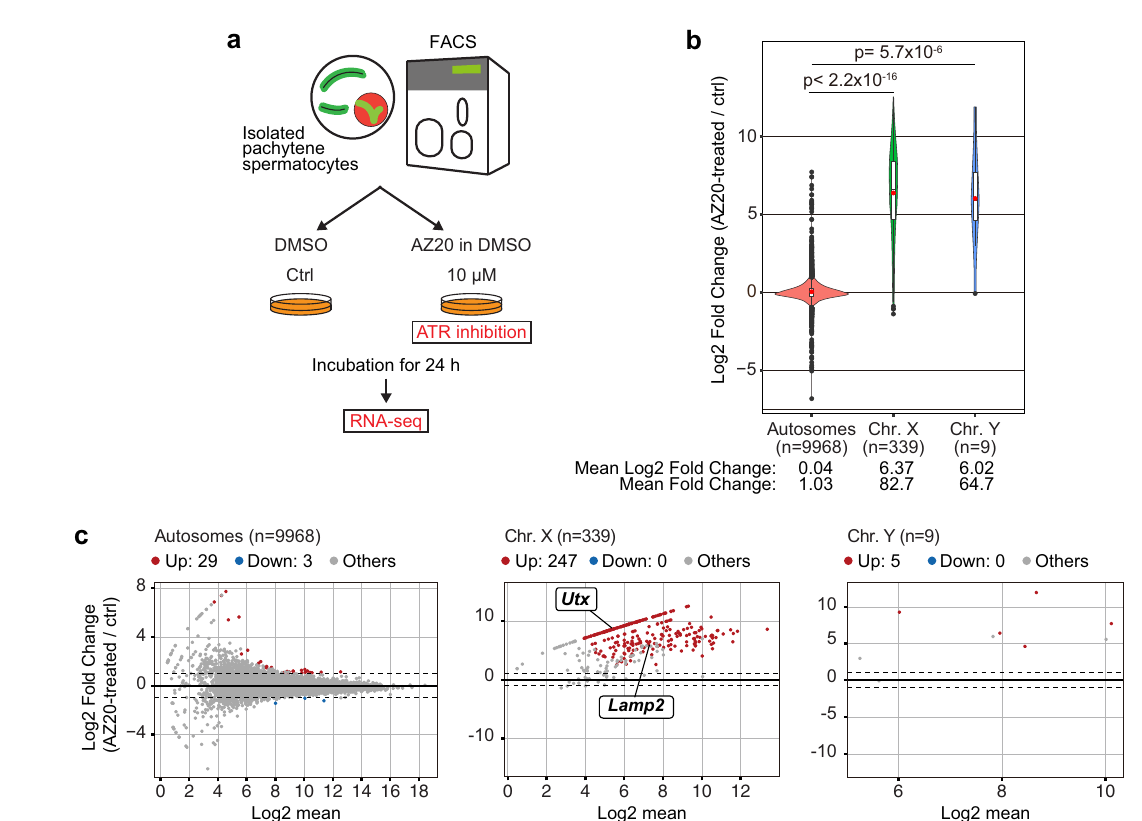
Fig. 2 | Gene suppression under MSCI is directed by ATR-dependent DDR sig- naling.a Schematicof theexperimental designfor RNA-seq analyses. b Violinplot with a Box plot overlay of the gene expression log2 fold change between AZ20- treatedandctrlspermatocytes.Thecentrallinesrepresentmedians.Theupperand lower hinges correspond to the 25th and 75th percentiles. The upper and lower whisker are extended from the hinge to the largest value no further than the 1.5x inter-quartilerange(IQR)fromthehinge.Log2foldchangesexceeding1.5xIQRare shown by black dots. Red dots in the Box plot are the average of the log2 fold change. The two-sided p -values were calculated using a Wilcoxon rank sum test.